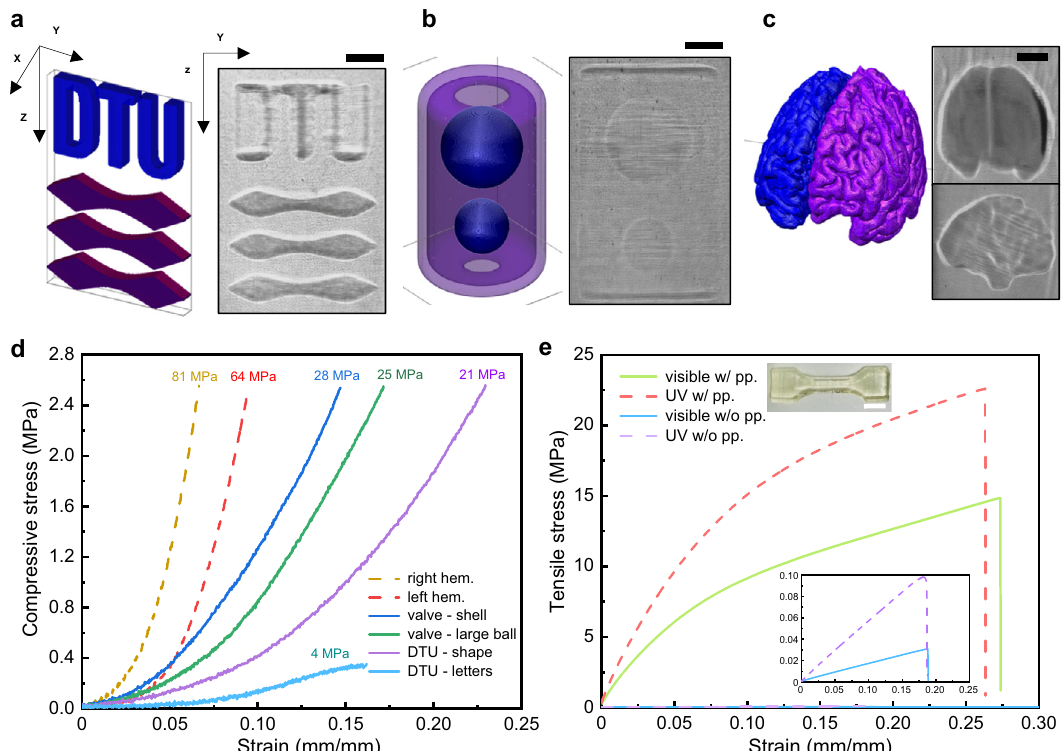
Fig. 2 Stiffness can be controlled in workpieces of complex shape and in all three Cartesian directions. a Stiffness control in the vertical direction. Left: dual-color design of a DTU logo, in which the letters are cured using visible light and the three stylized lions (shape) below using UV. This is a suspending structure that would require auxiliary support if built using conventional AM methods. Right: A DTU logo printout fl oating in viscous resin, captured by the surveillance camera. DCTVP can print this multimaterial workpiece in one shot without auxiliary support. b Stiffness control in a nested structure. Left: dual-color design of two encaged balls (valve). The hard shell is cured using UV while the soft balls inside using visible light. Right: a snapshot of the polymerized workpiece captured by the surveillance camera. c Dual-color design of a 3D brain model (left). The left hemisphere is cured using visible light and the right hemisphere using UV. Two surveillance snapshots of a printout with good geometric fi delity are shown on the right. The front view